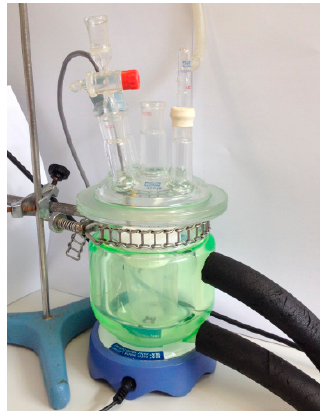
Figure 4. Thermostated cell for conductivity tests in solutions.